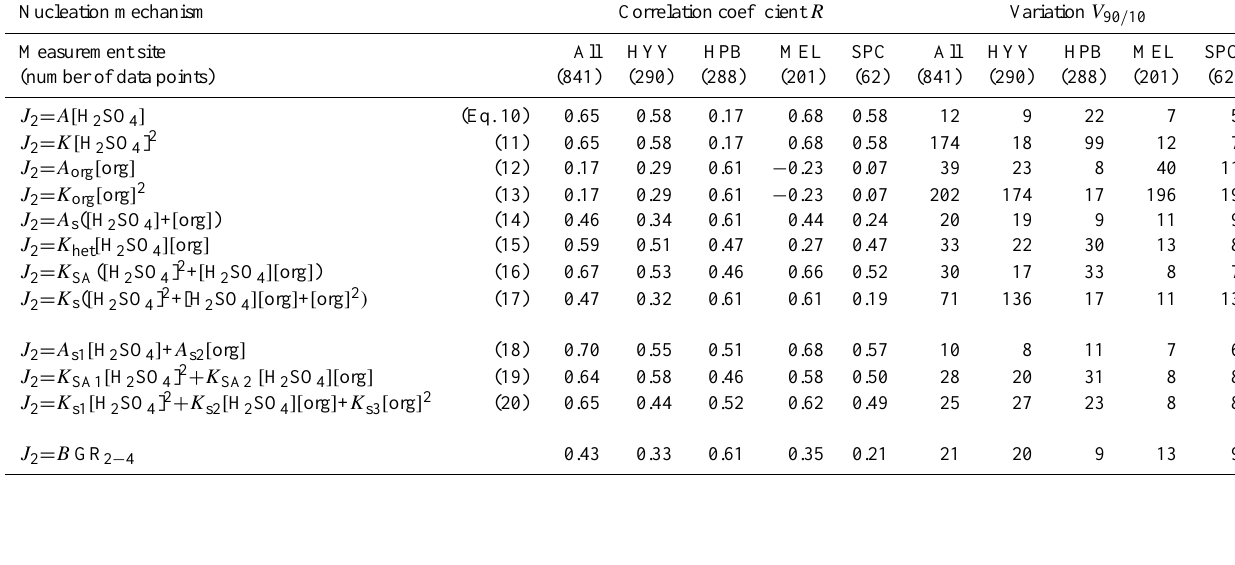
Nucleation mechanism